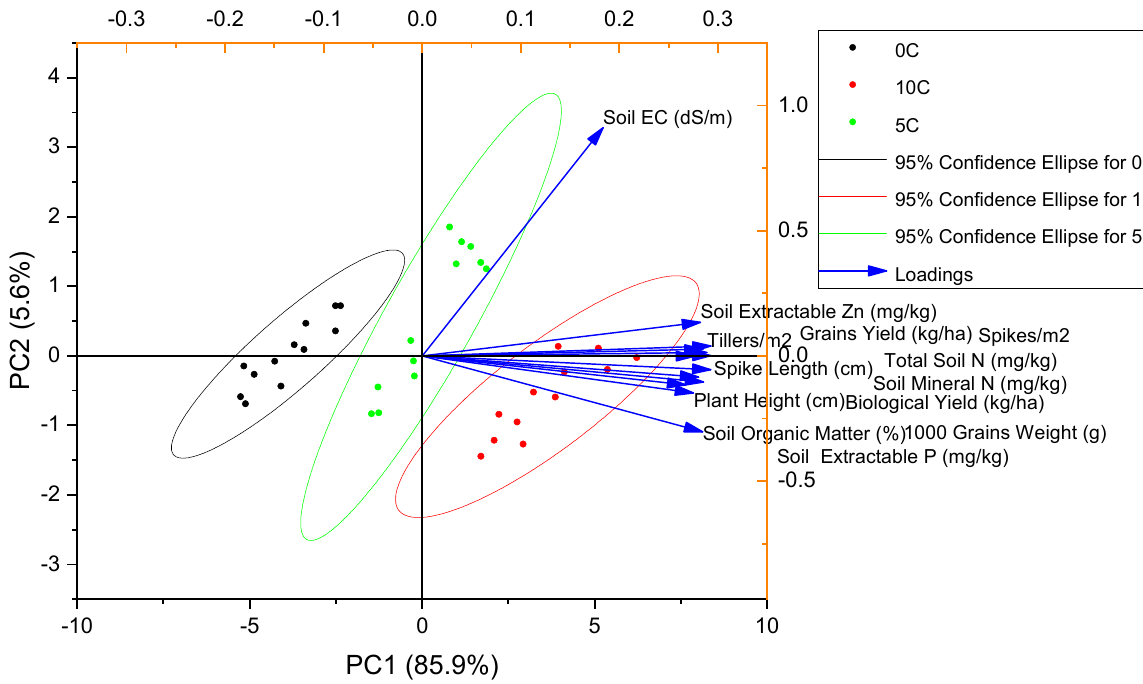
Figure 6. Principal component analysis for different studied attributes.